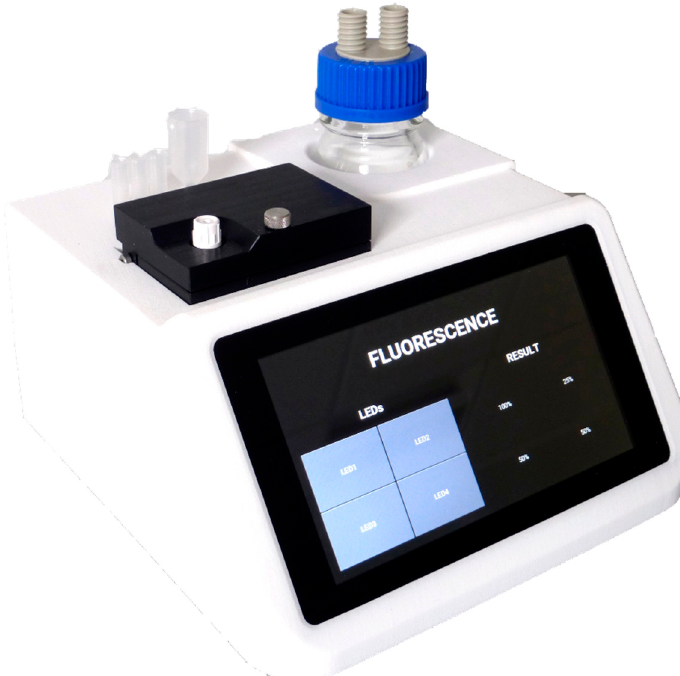
Figure 3. Platform.